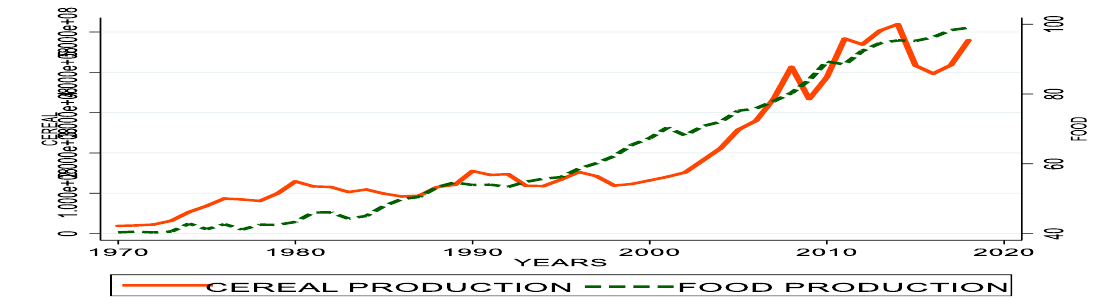
Figure 2: Evolution of Food Production and Gdp Growth in Ss Africa. Figure 2: This Figure Illustrates The Cointagration Movement Between Gdp and Food Production As the Main Contributors to Africa's Gdp Growth (Suri & Udry, 2022).